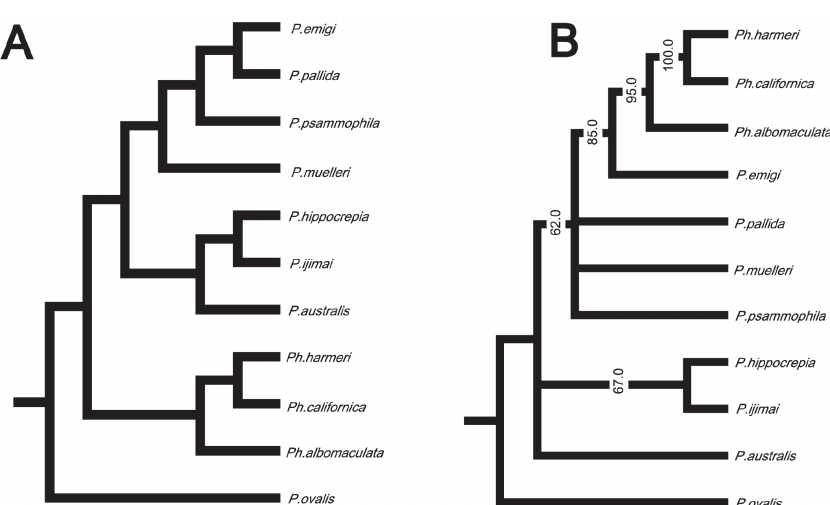
Supplementary Figure S1. A Cladogram of single-linkage cluster analysis among 11 phoronid species based on 23 morphological characters excluding nephridial characters B majority-rule consensus tree of 100 equally parsimonious tree obtained by cladistics analysis among 11 phoronid species based on 23 morphological characters excluding nephridial characters. Numerals on nodes indicate frequency values.